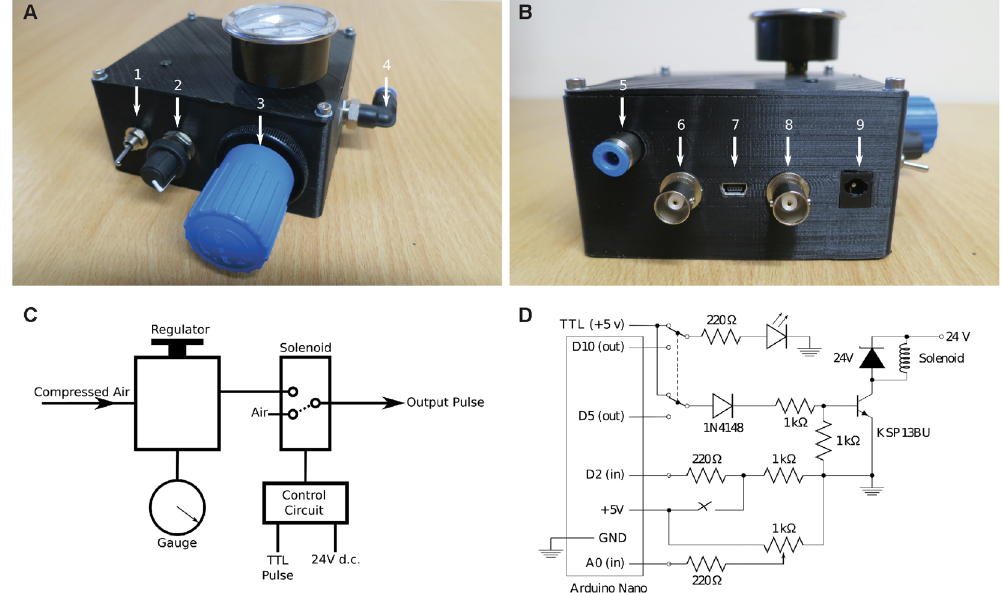
Figure 1. Openspritzer employs a fast switching solenoid to control the duration of a puff of compressed air. ( A ) Front panel view. Arrow 1: switch between external TTL pulse control or internal Arduino control. 2: potentiometer sets the internal pulse duration with feedback via light emitting diode (LED). 3: pressure regulator. 4: compressed air input port. ( B ) Back panel view. 5: compressed air output port. 6: Remote operation BNC connector (for a push-to-close SPST switch e.g. a footswitch). 7: USB port for + 5 V Arduino power and software uplink. 8: TTL pulse input via BNC connector. 9: 24 V DC supply for the solenoid. ( C ) System schematic. The solenoid switches state when the + 5 V TTL input is high, connecting the air input to the puffer output. When open the puffer output is connected to atmospheric pressure. The smallest achievable pulse time is less than 10 ms and limited by the solenoid switching speed. ( D ) Full circuit diagram. Internal or external control is selected via the Double Pole Double Throw (DPDT) switch. On internal control the pulse duration is selected by the potentiometer and flashes the LED to indicate the setting. The pulse is activated by a remote foot switch. The main solenoid circuit employs a darlington pair, represented as a single high gain transistor, to control the 114 mA solenoid via the low current Arduino pin 5 (40 mA max) and employs a number of protection diodes to prevent back emf from the solenoid from blowing the transistor or the